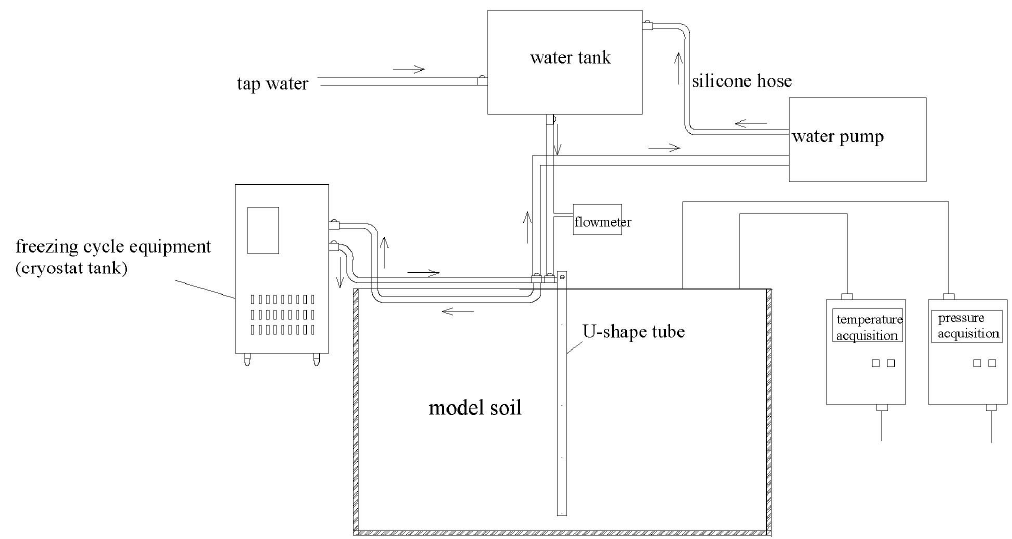
Figure 3. The experimental system schematic.